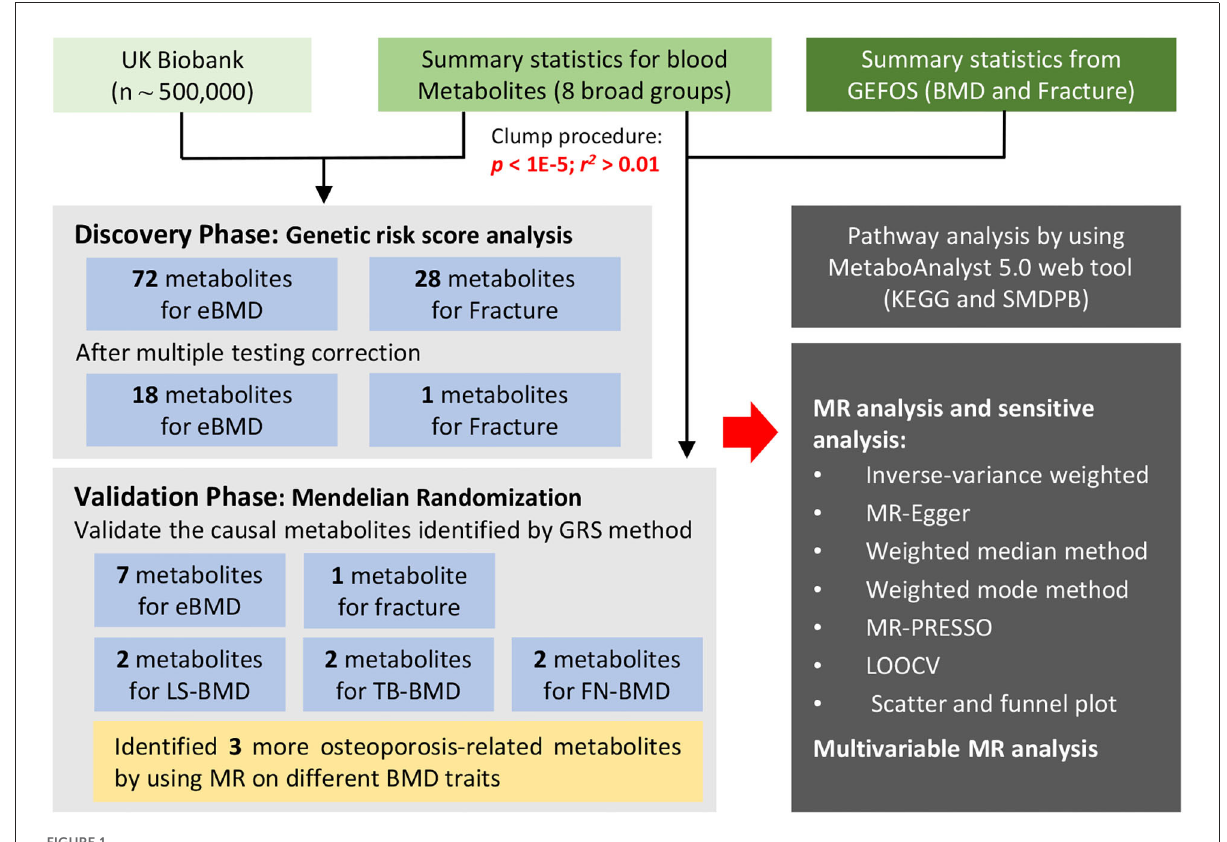
FIGURE1 The overview of the research